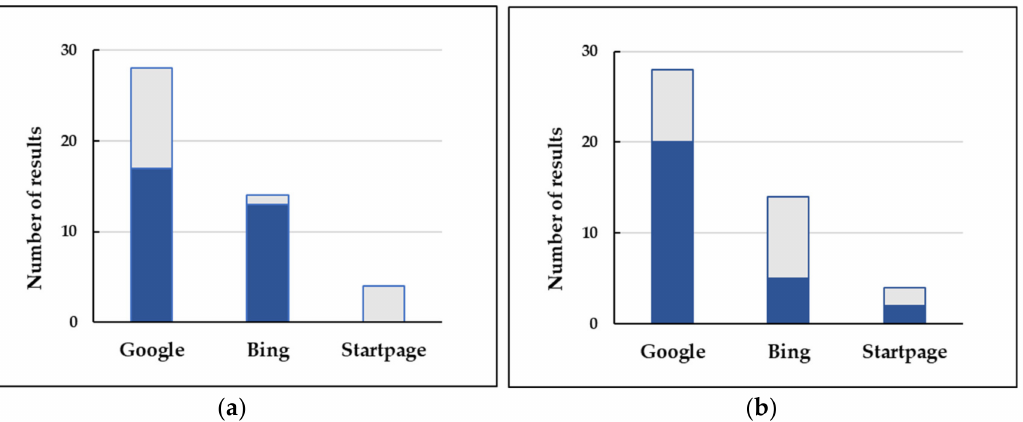
Figure 2. Number of selected web pages found using the three search engines: ( a ) On the first (blue) and the second search page (grey); ( b ) Per period of time: any time (blue) and past year